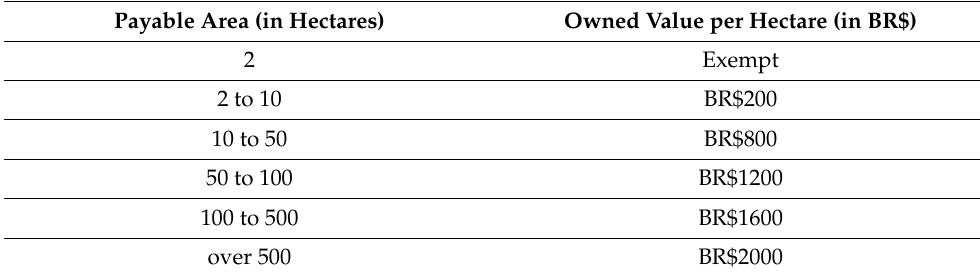
Table 2. Set of fine values for illegal deforestation in Goi á s state, depending on size (hectares), after 27 December